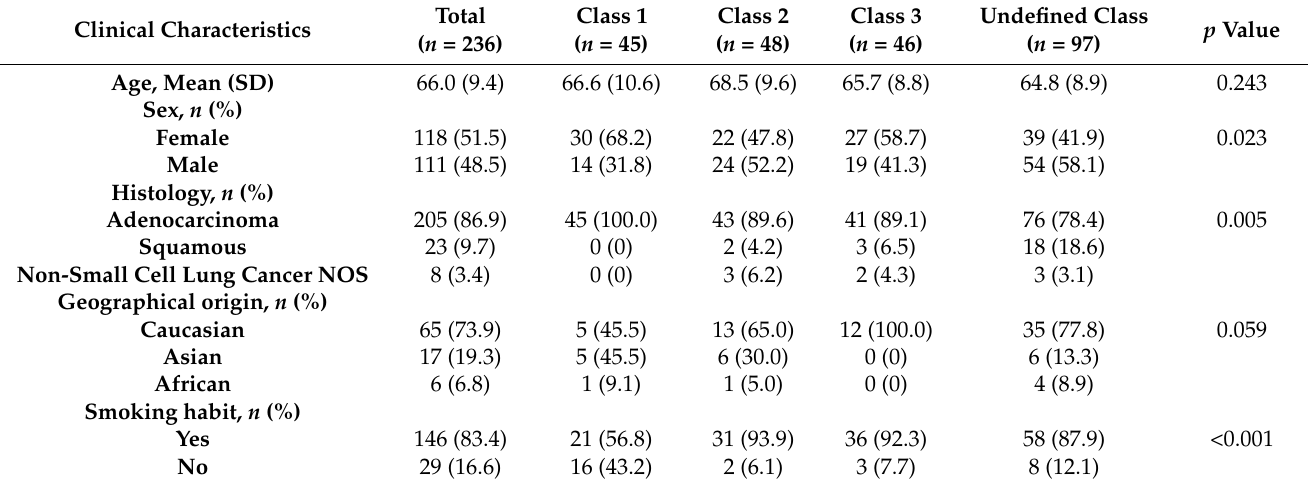
Table 1. Main clinical characteristics of patients harboring BRAF alterations detected through the analysis of the